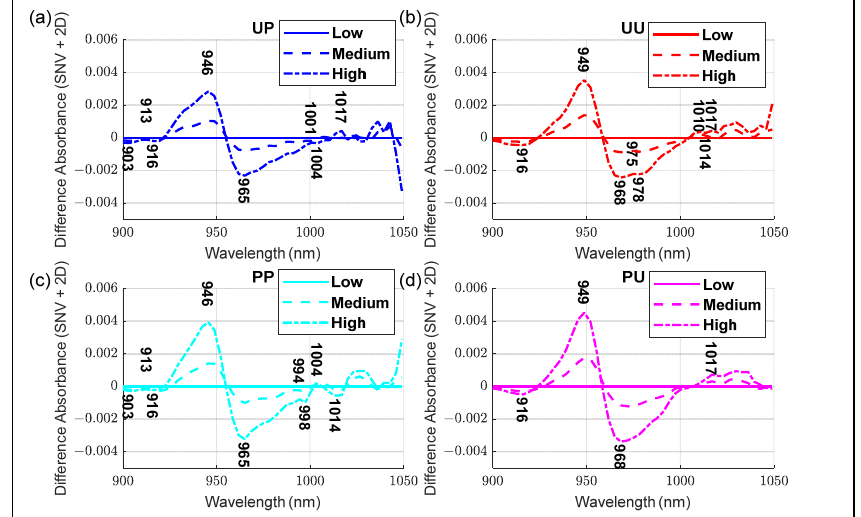
Figure 6. Standard Normal Variate (SNV) + 2D Soluble Solids Content (SSC) Difference Spectra for each configuration. ( a ) Unpeeled Polarized, ( b ) Unpeeled Unpolarized, ( c ) Peeled Polarized and ( d ) Peeled Unpolarized kiwifruit. Low, medium and high designations are represented by solid, dashed and dashed ‐ dot lines, respectively.